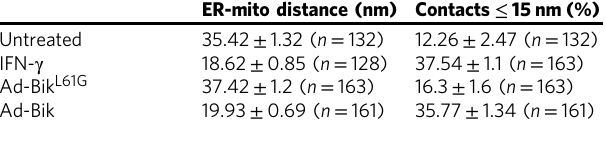
Table 1 Measurements of ER-mitochondria